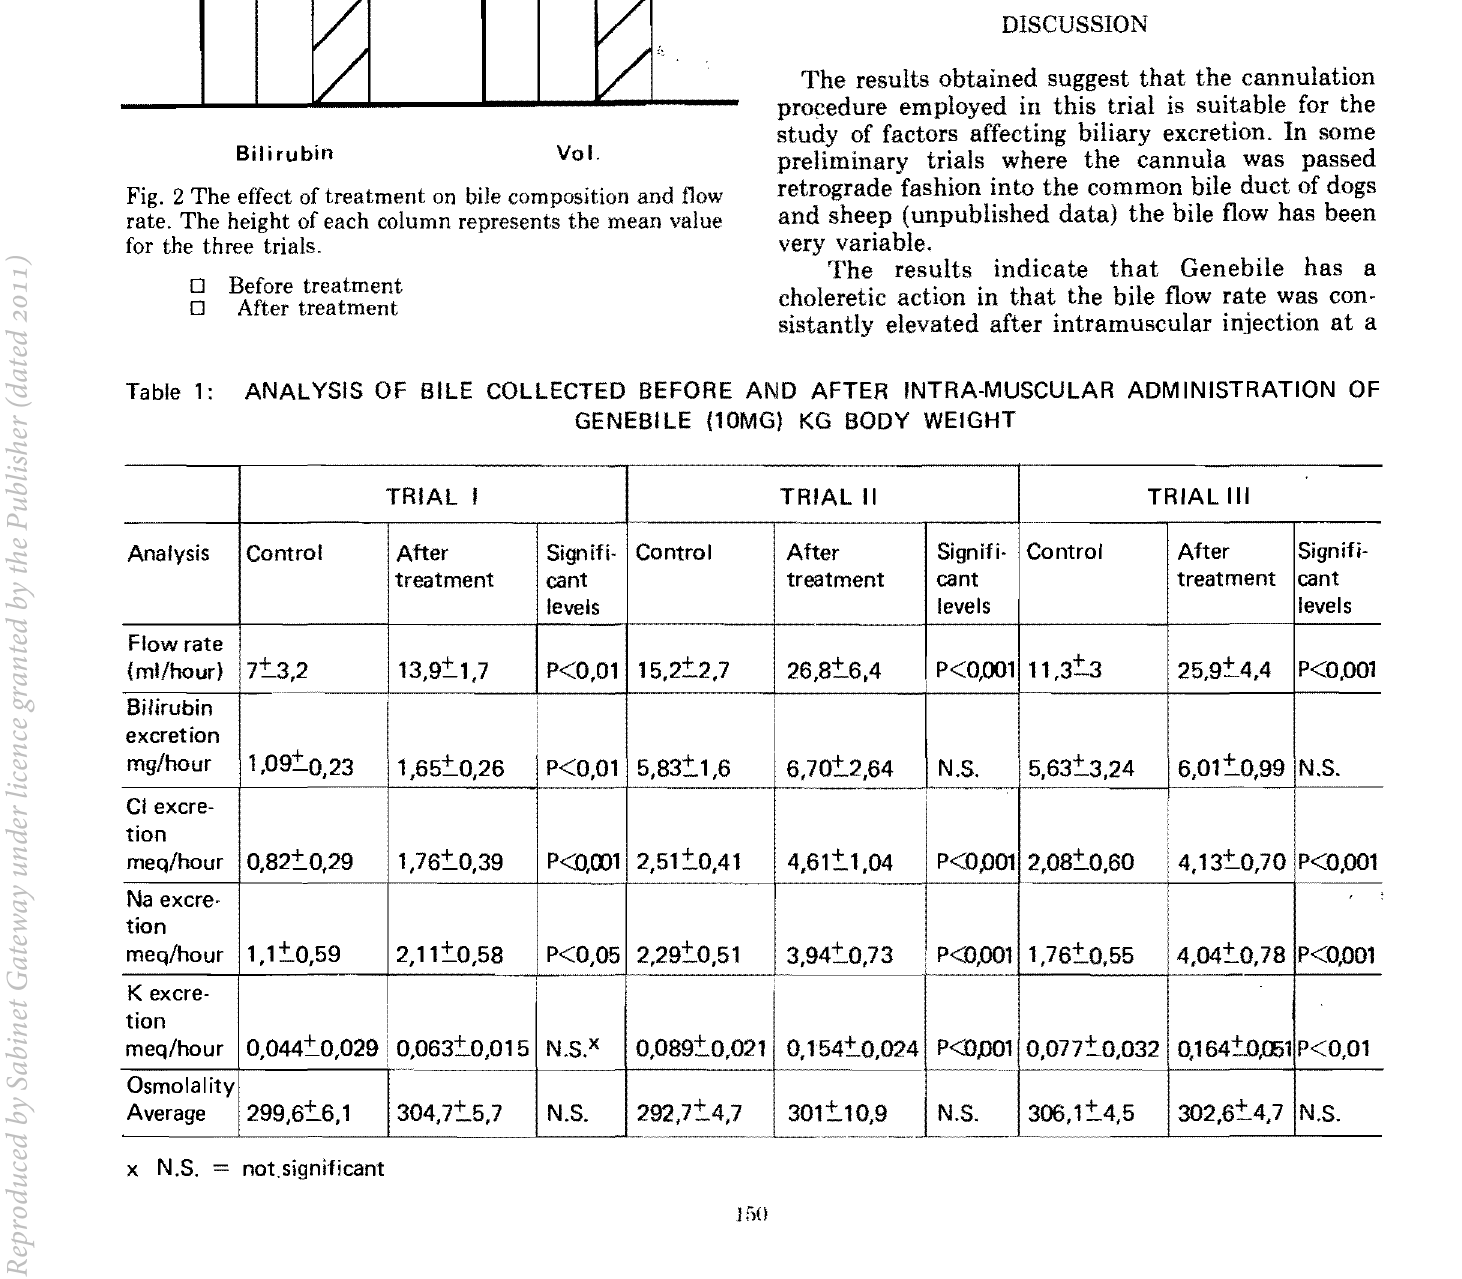
Fig. 2 The effect of treatment on bile composition and flow rate. The height of each column represents the mean value for the three trials.